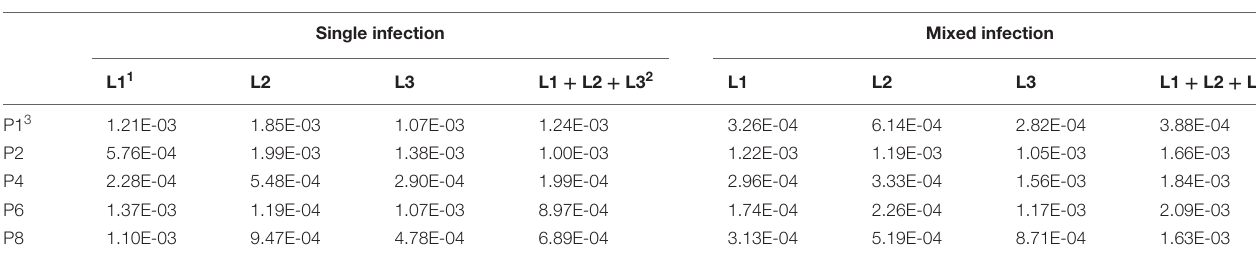
TABLE 3 | PepMV-CH2 nucleotide diversity ( π ) along passages. Single infection Mixed